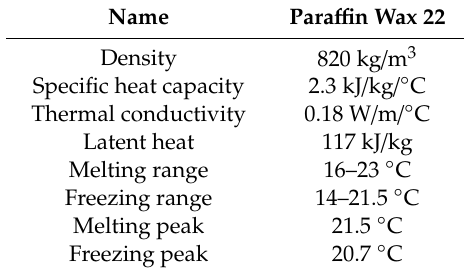
Table 1. The thermal properties of the PCM in the experimental setup [31].